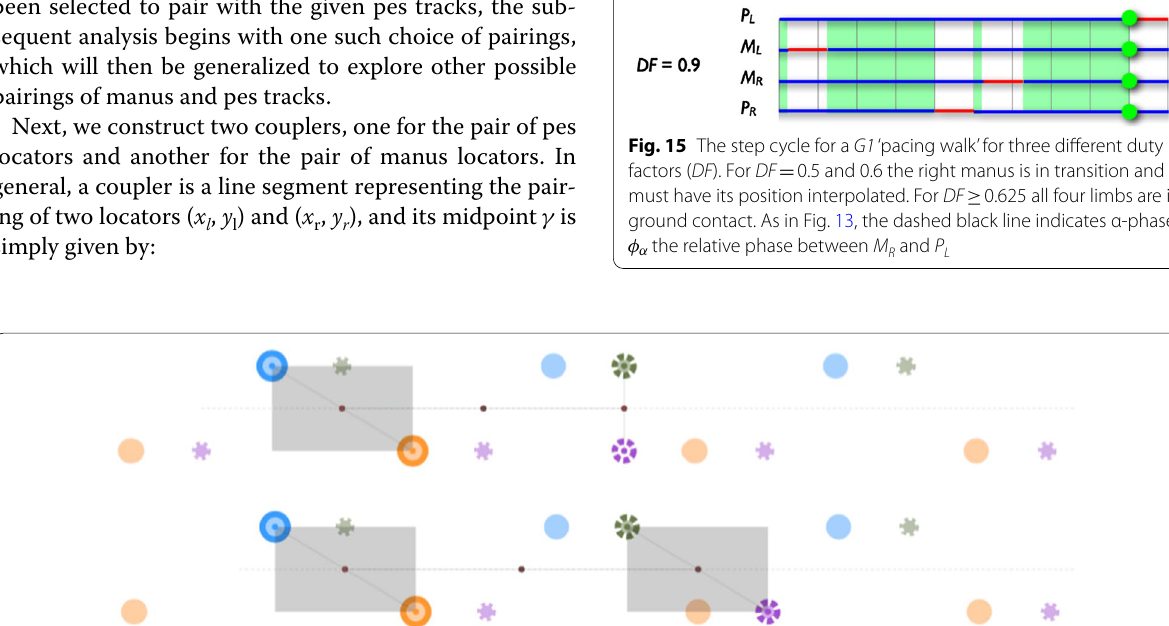
Fig. 14 An idealized trackway with two simulations wherein the left pes is about to finish the support phase. In the upper diagram the duty factor is only 0.5 and therefore the right manus M R is still in transition. In the lower diagram, the duty factor is 0.75 and now M R has just completed its step. Notice the difference in CL for the two cases